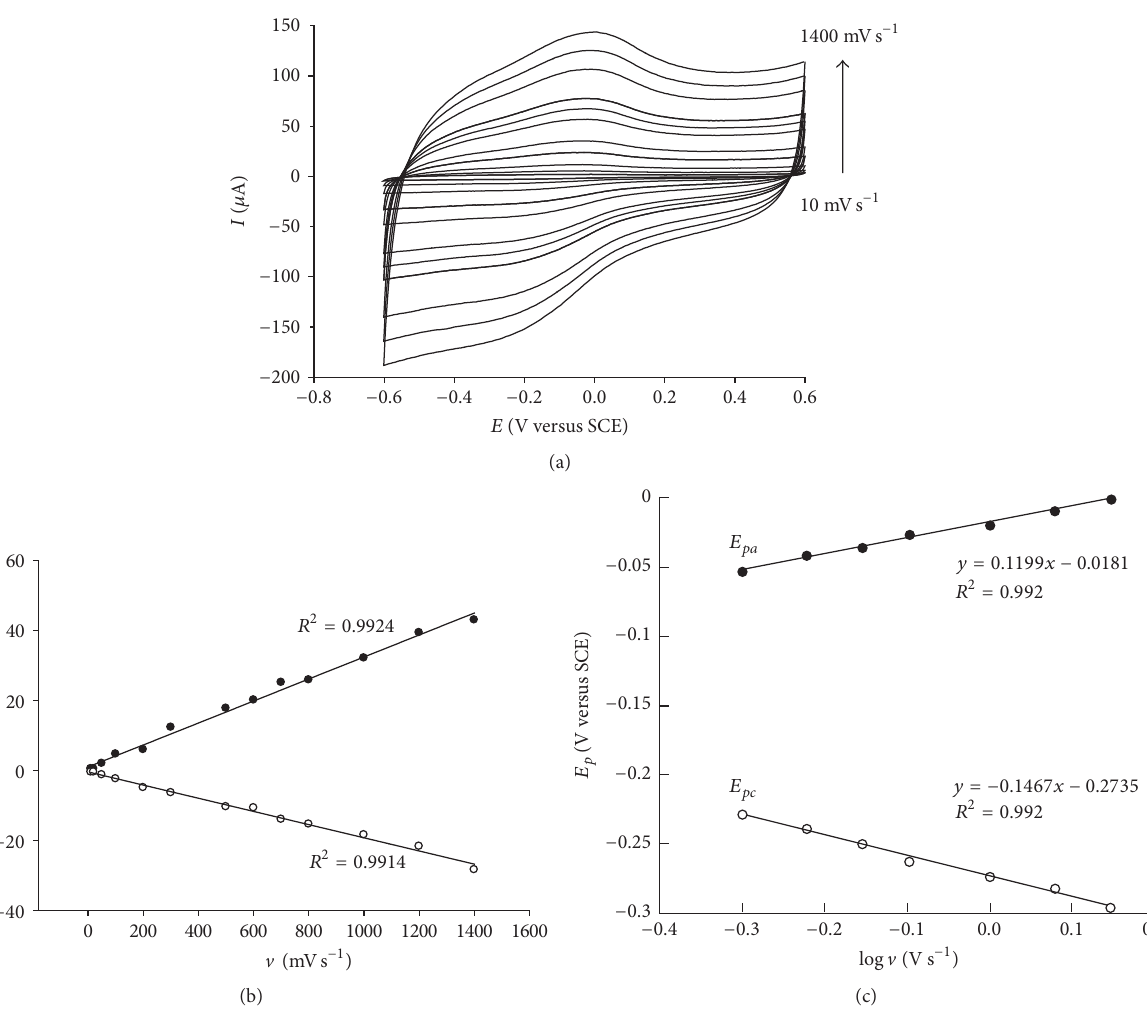
Figure 3: CVs for NAF-MWCNTs-COOH-GCE-CAT in deoxygenated PBS buffer solution at various scan rates (a). Relationship between the anodic and cathodic peak currents and scan rates (b). Relationship between peak potential separation and logarithm of scan rates